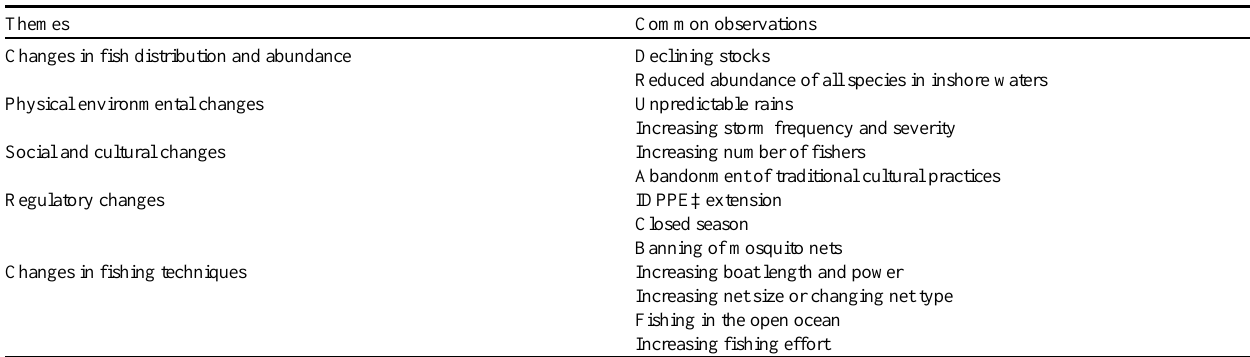
Table 1. Common observations of change as described by fishers at Zalala Beach.†